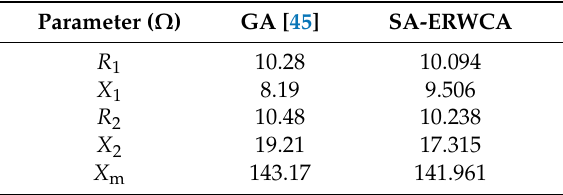
Table 18. Results for GA and SA-ERWCA for Machine 4.